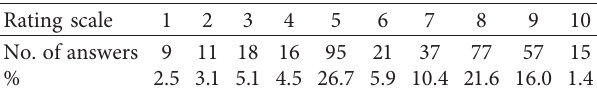
Table 8: Kyiv IGSE administrators’ view on cut-down in face-to- face meetings in favour of those with modern gadgets and mes- senger